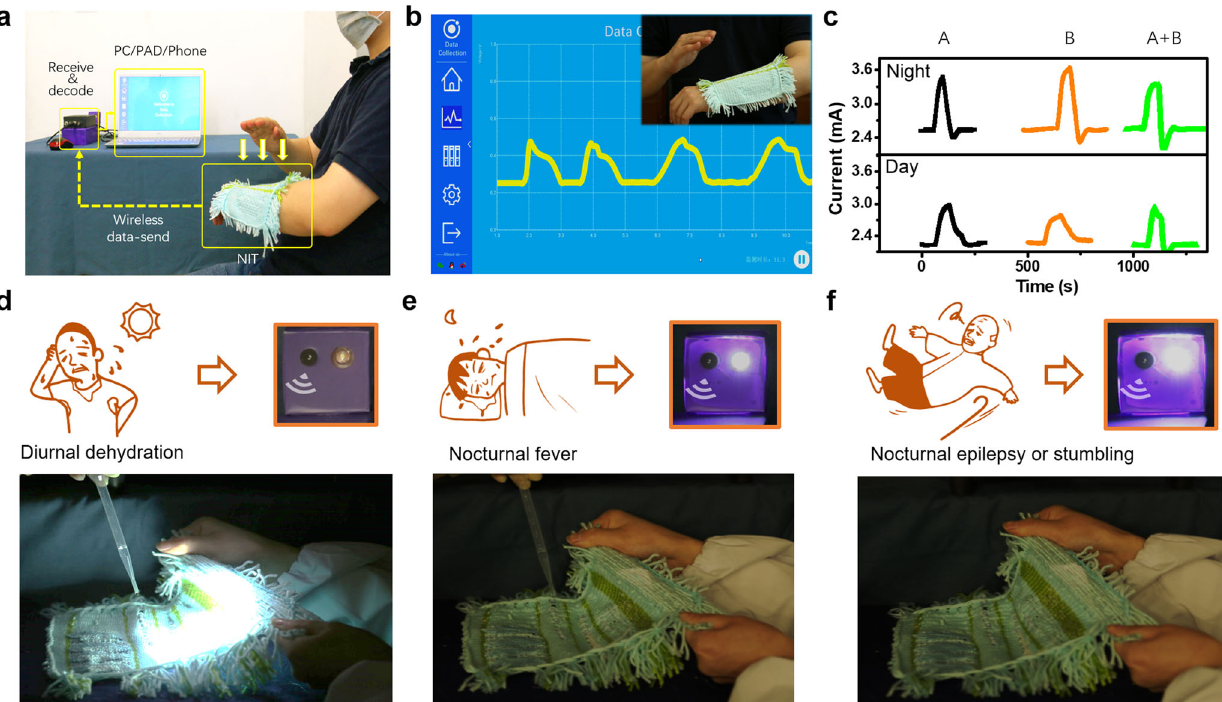
Fig. 5 Function veri fi cation of a prototype for both wireless data-sending and emergency alarms. a An illustration of wirelessly sending body-motion data from the NIT to a tablet PC in the lab. b The wireless data pro fi le from the fabric. c The received signal level for different scenarios in night-time or day- time: A. body moving, B. sweating. The fabric can send different logical binaries by itself to determine alarm types for different simulated emergencies: ( d ) sound only alarm for abnormal pH value change under light illumination, ( e ) both sound and light alarm for abnormal pH value change in the dark, ( f ) both sound and light alarm for the stretching or hitting on the body in the